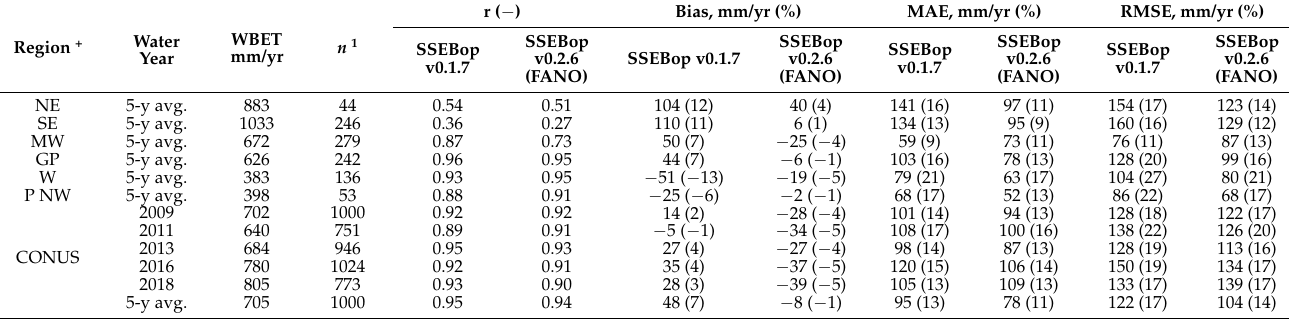
1 : n = number of HUC8s for ETa comparison between SSEBop (identical HUCs on two versions) and WBET. + : NE = Northeast; SE: Southeast; MW: Midwest; GP = Great Plains; W: West; P NW = Pacific Northwest. The regional HUC8 ETa comparison of SSEBop v0.1.7 and SSEBop v0.2.6 (FANO) with WBET is shown in Figure 8. Overall results indicate a better performance of SSEBop v0.2.6 (FANO) over SSEBop v0.1.7. Bias is reduced from SSEBop v0.2.6 (FANO) at all regions, resulting in within ± 5% (Table 3). MAE and RSME are also lower from SSEBop v0.2.6 (FANO) at all regions except the Midwest region. The SSEBop v0.1.7 shows positive bias at the Northeast and Southeast regions (>10%), but these magnitudes are lowered by SSEBop v0.2.6 (FANO) (<5%). Similarly, the high negative bias by SSEBop v0.1.7 at the West and Pacific Northwest regions ( ≥ 6%) are lowered by SSEBop v0.2.6 (FANO) ( ≤ 5%). The overall pattern of positive bias at the eastern regions (Northeast and Southeast) and negative bias at the western regions (West and Pacific Northwest) remain similar from both versions of SSEBop. However, the positive bias from SSEBop v0.1.7 at the Midwest and Great Plains regions show with a smaller negative bias with SSEBop v0.2.6